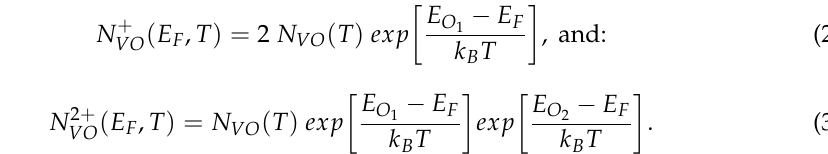
Figure 3. ( a ) Energy levels of oxygen vacancies relative to the conduction and valence band edges in SnO 2 ; ( b ) transfer of electrons from occupied donor levels to a deeper-lying electron Fermi-energy (left); re-excitation of electrons from the Fermi energy to the conduction band (right). With the donor levels transferring their electrons to a deeper-lying Fermi energy, the vacancies change their formal charge states from zero to positive and double-positive and they also refund a fraction of their formation energy to the thermal reservoir of lattice vibrations inside the SnO 2 crystal. With these lowered formation energies, the volume densities of singly and doubly ionized vacancy sites are significantly enhanced over the volume density of neutral donor sites and, in particular, the volume densities of these charged vacancies become